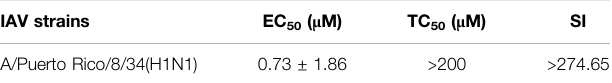
TABLE 2 | Inhibition effects of ISO on the A/Puerto Rico/8/34(H1N1) strain. Selectivity index (SI) (cid:2) EC 50 /TC 50 . IAV strains EC 50 ( μ M) TC 50 ( μ M) SI A/Puerto Rico/8/34(H1N1) 0.73 ± 1.86 > 200 >